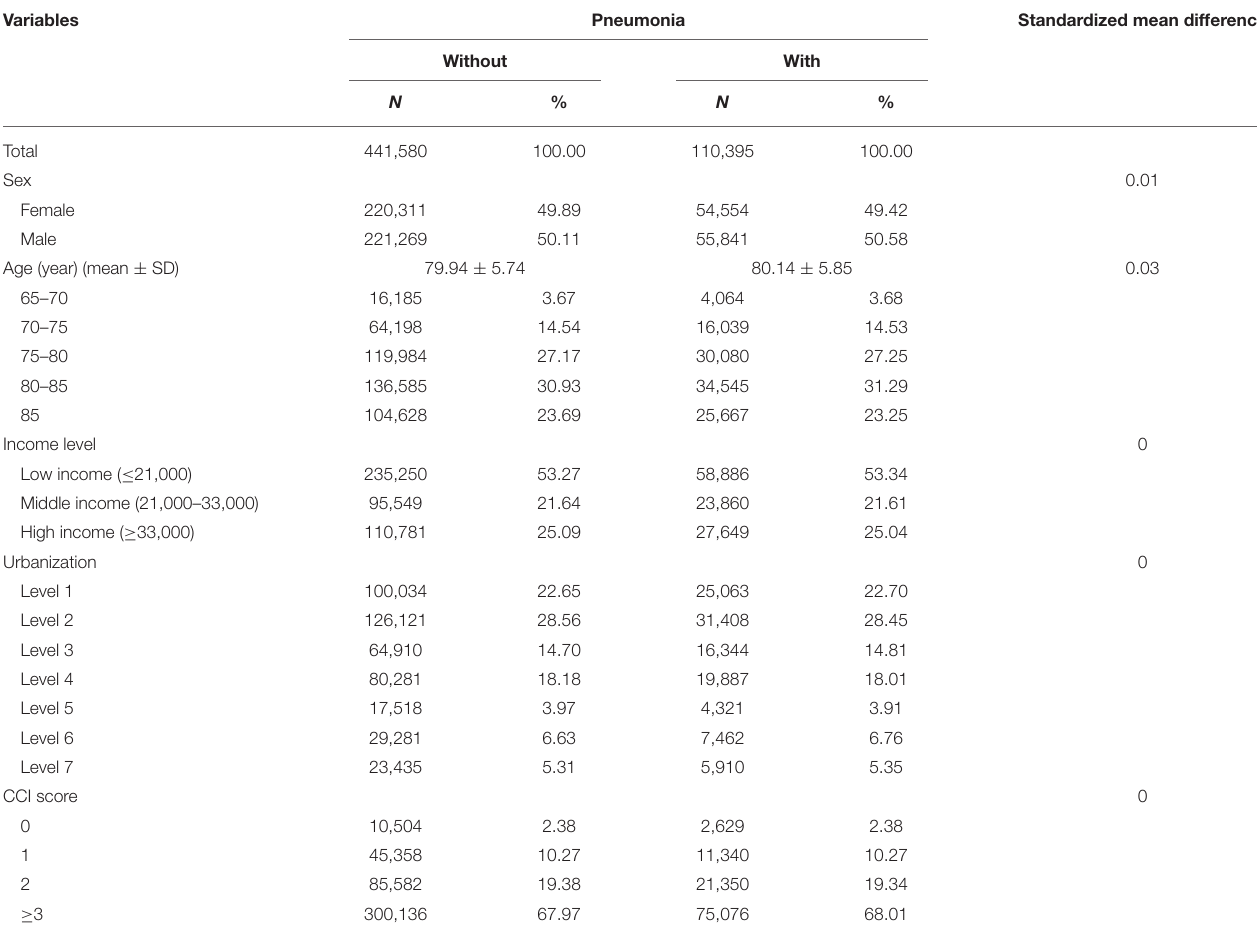
TABLE 1 | The baseline characteristics of elderly patients with Parkinson’s disease after matching. Variables Pneumonia Standardized mean